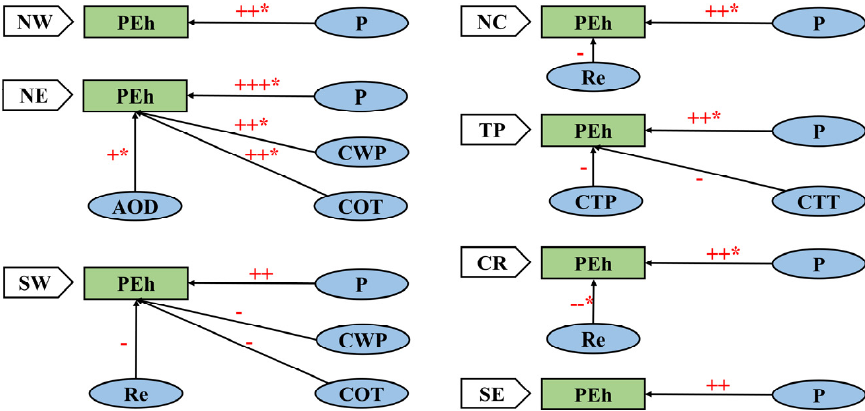
Figure 15. A schematic representation of the possible factors which influence summer PEh in the seven sub-regions of China. The red +/ − , ++/ −− , ++*/ −− *, +++*/ −−− * represent low increase/decrease, moderate increase/decrease, moderate increase/decrease which passes significance at the level of 0.05, high increase/decrease which passes significance at the level of 0.05.